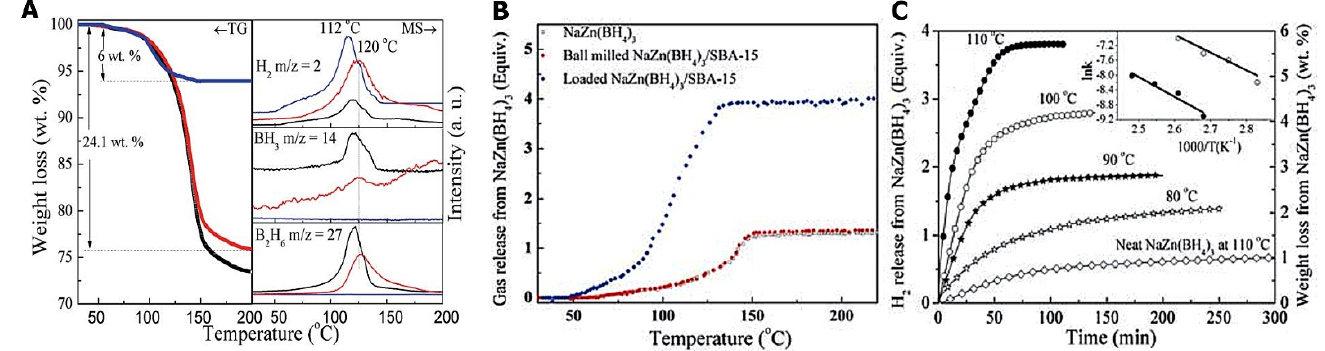
Figure 19. ( A ) TGA and MS results for pure NaZn(BH4)3 (black line), ball milled NaZn(BH 4 ) 3 /SBA-15 (red line) and loaded NaZn(BH 4 ) 3 /SBA-15 (blue line),with a heating rate of 2 C/min under dynamic Ar atmosphere. The right axis of the TGA chart gives the amount of weight loss relative to the mass of NaZn(BH 4 ) 3 only. ( B ) Volumetric gas release measurements for pure NaZn(BH 4 ) 3 (black line), ball milled NaZn(BH 4 ) 3 /SBA-15 (red line) and loaded NaZn(BH 4 ) 3 /SBA-15 (blue line), with a heating rate of 2 °C/min under 1 atm argon, expressed with respect to the content of NaZn(BH 4 ) 3 only. ( C ) Isothermal volumetric results for gas release from the loaded NaZn(BH 4 ) 3 /SBA-15 composite at 80 °C, 90 °C,100 °C and 110 °C, and for pure NaZn(BH 4 ) 3 at 110 °C. The inset shows a comparison of the Arrhenius plots of the temperature-dependent rate data of the loaded NaZn(BH 4 ) 3 /SBA-15 composite (full circles) and the pure NaZn(BH 4 ) 3 (empty circles). This figure was reprinted with permission from ref. [267].